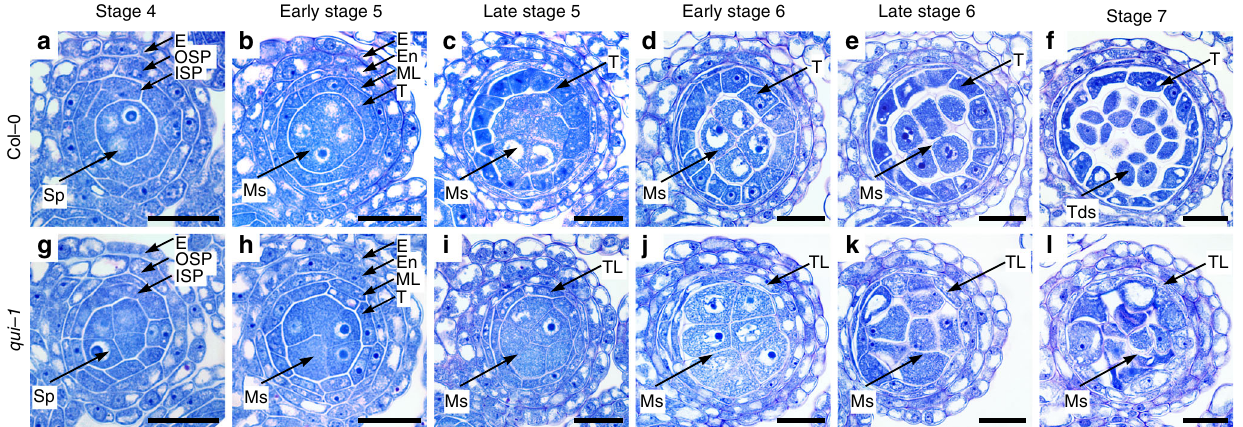
Fig. 2 qui-1 shows impaired tapetum differentiation and microsporogenesis starting from late stage 5. Semithin sections of anther lobes at different developmental stages from Col-0 ( a – f ) and qui-1 ( g – l ) after stained with toluidine blue. a , g Stage 4 anthers. The anthers from Col-0 and qui-1 showed no visible differences. b , h Early stage 5 anthers. The anthers from Col-0 and qui-1 showed no visible differences. c , i Late stage 5 anthers. Failed enlargement of tapetal cells and excessive microsporocytes were observed in qui-1 anthers. d , j Early stage 6 anthers. Signi fi cant excessive microsporocytes were observed in mutant anther locules. e , k Late stage 6 anthers. f , l Stage 7 anthers. Microsporocytes in qui-1 anthers cannot form tetrads. Epidermis (E), outer secondary parietal cell layer (OSP), inner secondary parietal cell layer (ISP), sporogenous cell (Sp), middle layer (ML), tapetum layer (T), tapetum-like layer (TL), microsporocytes (Ms), and tetrads (Tds) are indicated by arrows. Scale bars represent 20 μ